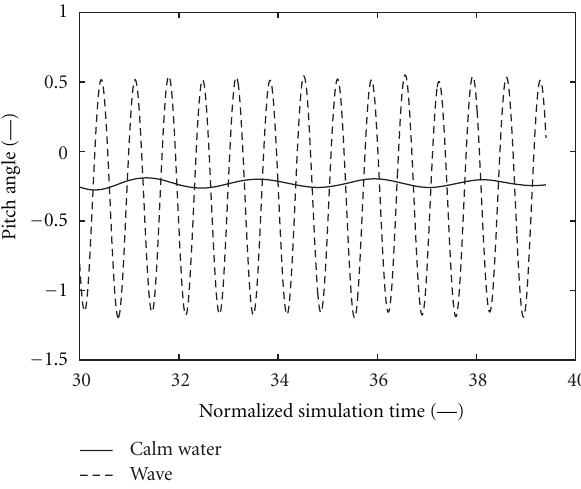
Figure 18: Evolution of the forward speed of the vessel over time. The solid line refers to the calm water case, while the dashed line displays the speed losses in waves.